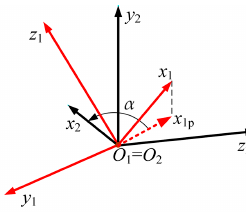
Figure 3. Definition of tapping angle.